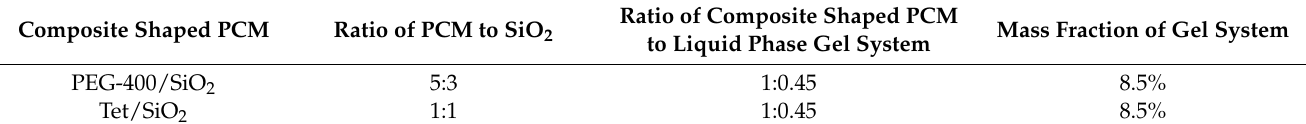
Table 2. Proportions of the composite shaped PCM.